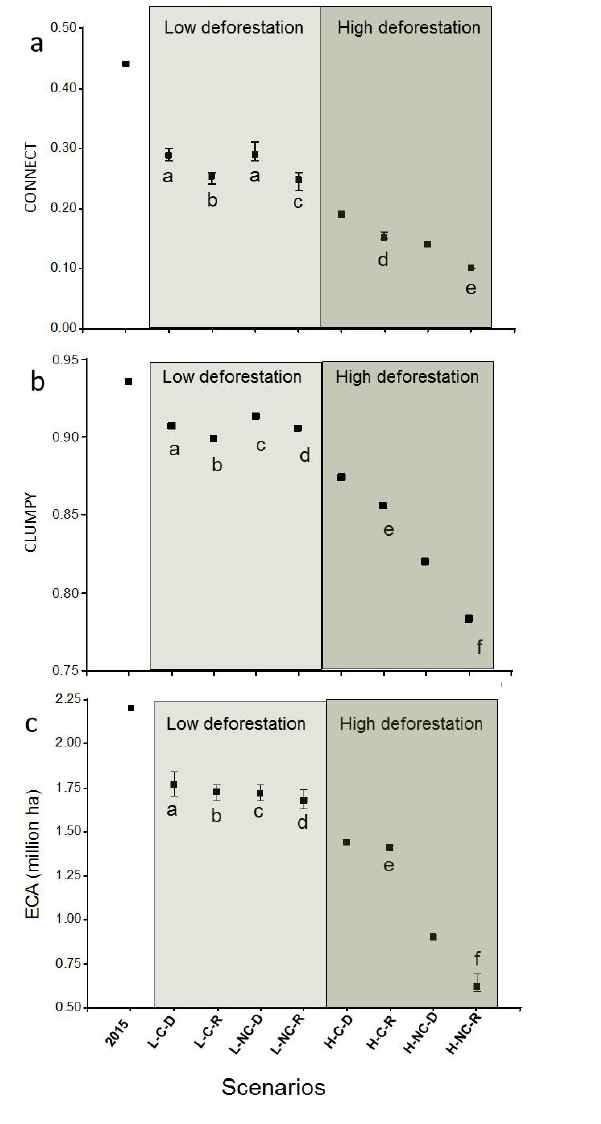
Fig. 6. Mean (min/max) values for forest connectivity indices in Formosa for 2015 and simulated deforestation scenarios. Scenarios differ in deforestation rates (L: low, H: high), spatial planning at the regional level (C: with corridors, NC: without corridors) and spatial planning at the plot level (D: design, R: random). Different letters inside the panel represent significant differences ( p < 0.05, see Appendix 3). CONNECT indicates the proportion of distances between patches below a certain threshold (2 km in our case); CLUMPY measures the aggregation of forest patches in the landscape; ECA is the size that a single forest patch should have in order to provide the same amount of reachable forest as the mosaic of forest patches in a given landscape. See text for a complete description of each